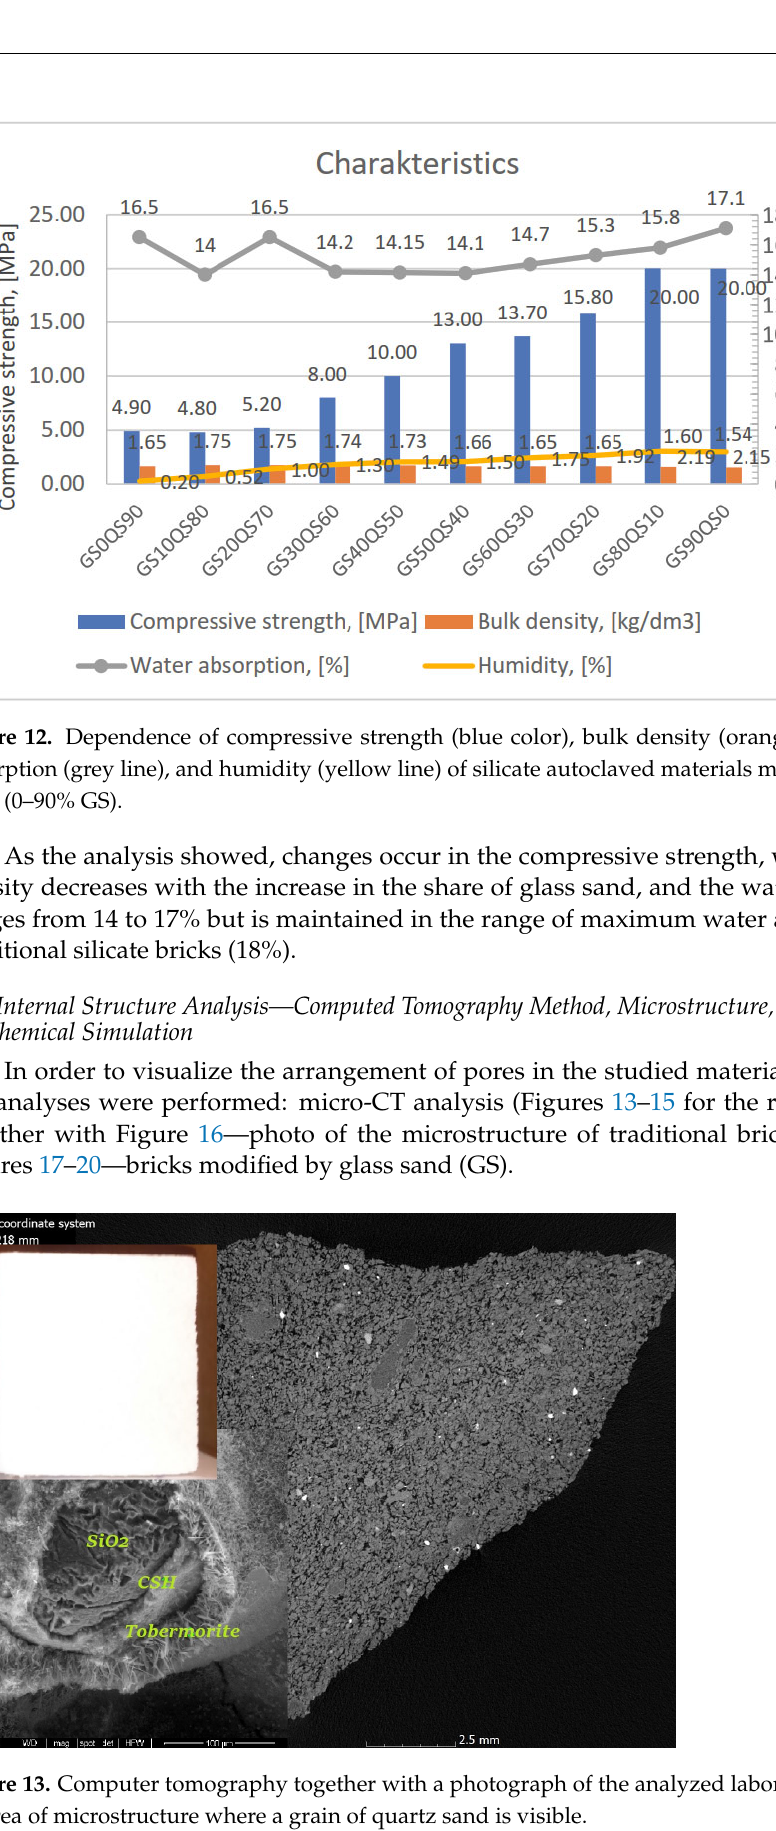
Figure 11. The cumulative volume of pores in the samples of silicate material: traditional (blue color), modified with 50% glass sand and 50% quartz sand (red color), and the material fully mod ‐ ified (90%) with glass sand (gray color) [78].